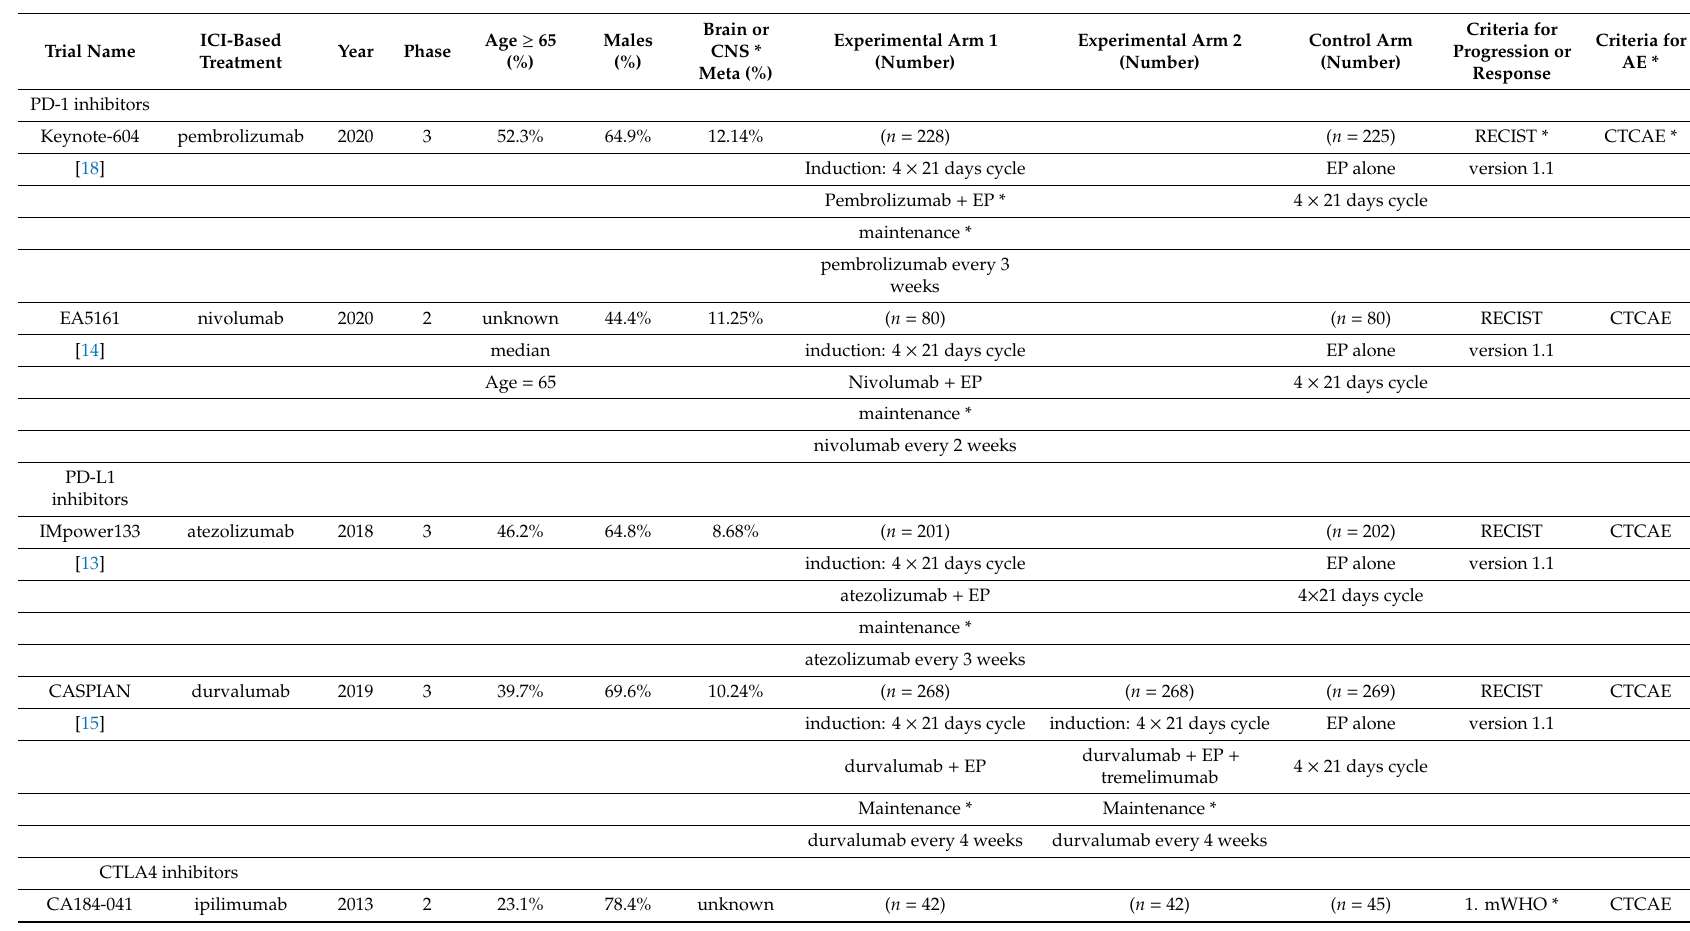
Table 1. Characteristics of the included